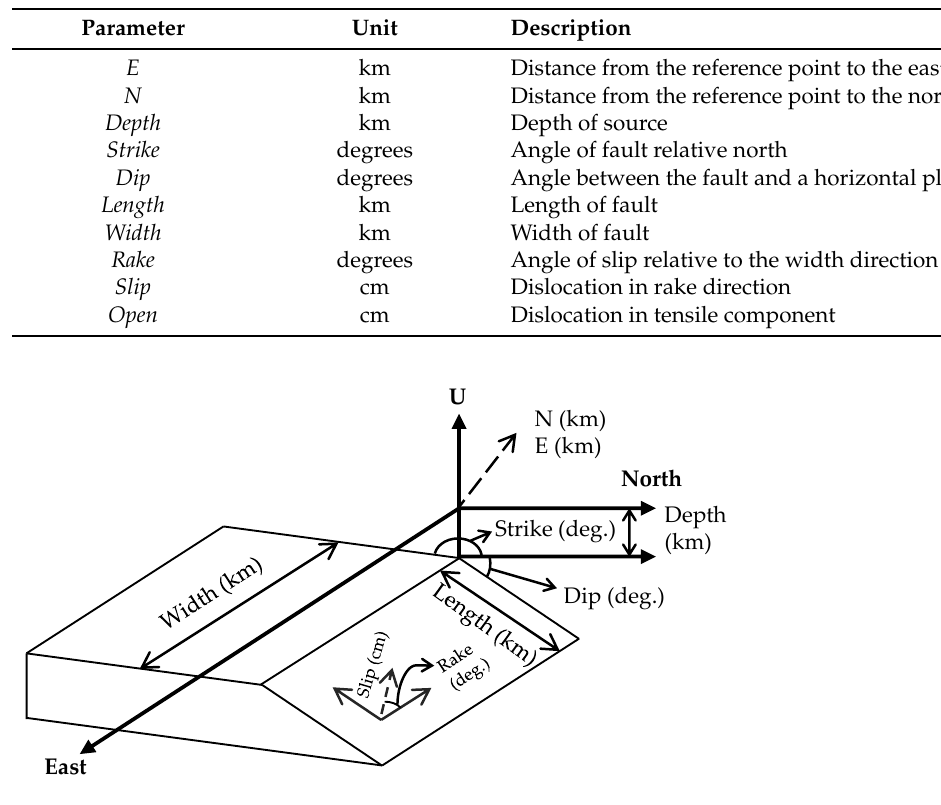
Figure 3. Fault geometry of the Okada model